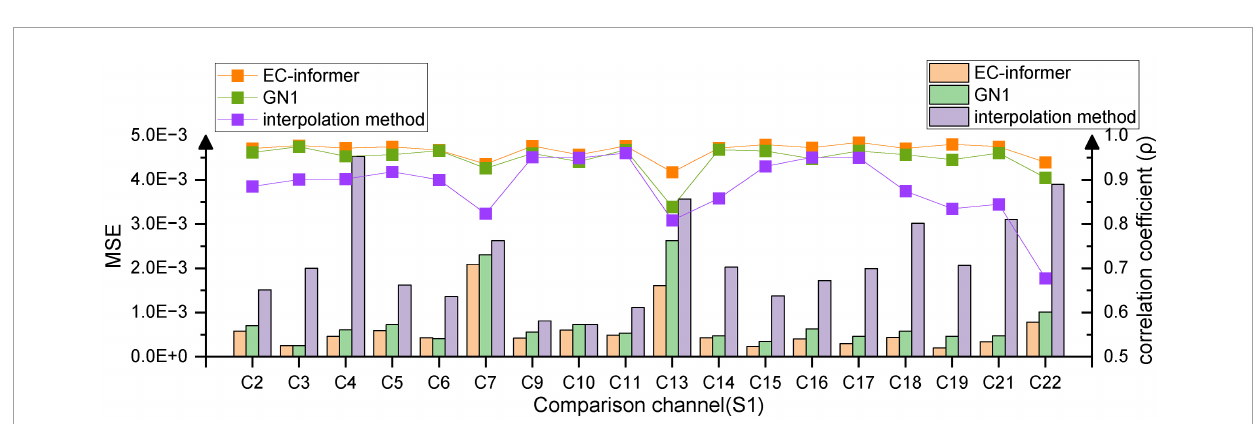
FIGURE9 Multi-channel completion effects. Using 1st, 8th, 12th, and 20th channels to supplement the information of the remaining 18 channels of Subject 1, compared to the other two methods, EC-informer retains the most